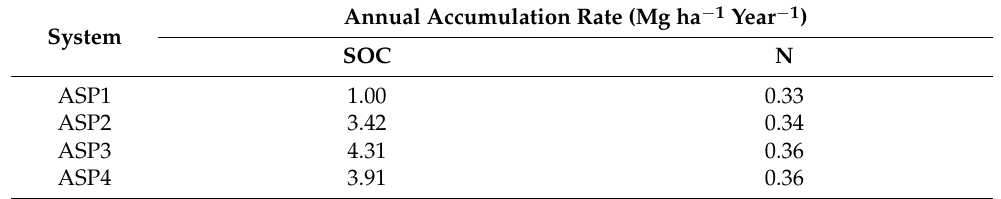
Table 3. Annual accumulation rate of SOC and N in the ASP systems compared to RS systems at 0–30 cm soil depth at Bonsucesso Farm, Minas Gerais State, Brazil. Systems: E. camaldulensis × E. tereticornis hybrid intercropped with buffel grass using the arrangements 2 × 3 + 10 m (ASP1) and 2 × 3 + 15 m (ASP2); E. urophylla × E. grandis hybrid intercropped with buffel grass using the